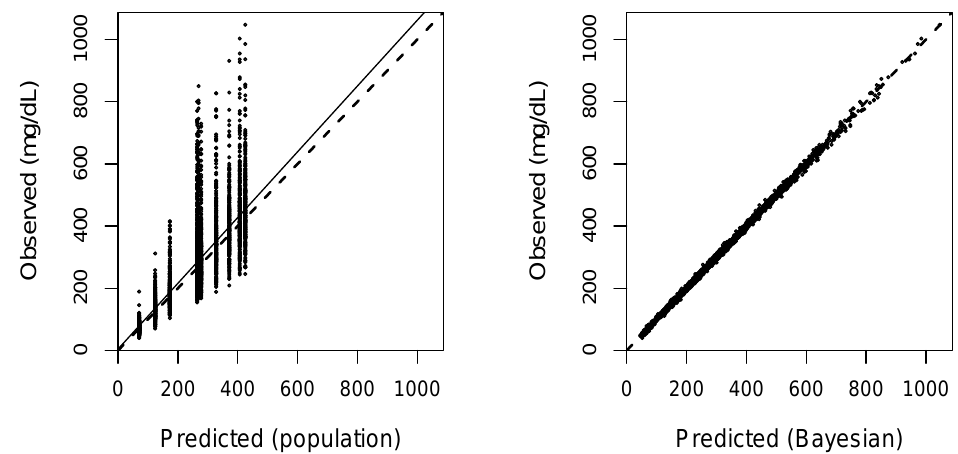
Figure A5. Predicted vs. Observed. Population Fit: r 2 = 0.569 , intercept = 3.8 ( CI 95% − 5.85,13.5 ) , slope = 1.12 ( CI 95% 1.08,1.15 ) ,bias = − 6.45, imprecision = 366. Individual Bayesian Posterior Fit: r 2 = 0.999, intercept = 0.168 ( CI 95% − 0.267,0.603 ) , slope = 0.998 ( CI 95% 0.997,1 ) , bias = 0.0612, imprecision = 1.15. Table A1. Simulation versus optimization. Row 1: True simulated means for each parameter. Row 2: NPAG estimates of corresponding means. Ka Vc Ke Kcp Kpc µ SIM 0.7948080 µ